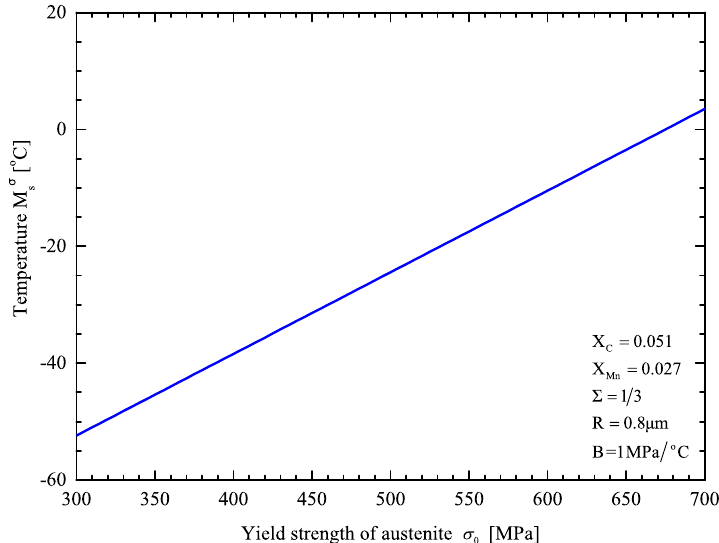
Figure 7. M σ s temperature as a function of yield strength σ 0 of retained austenite.